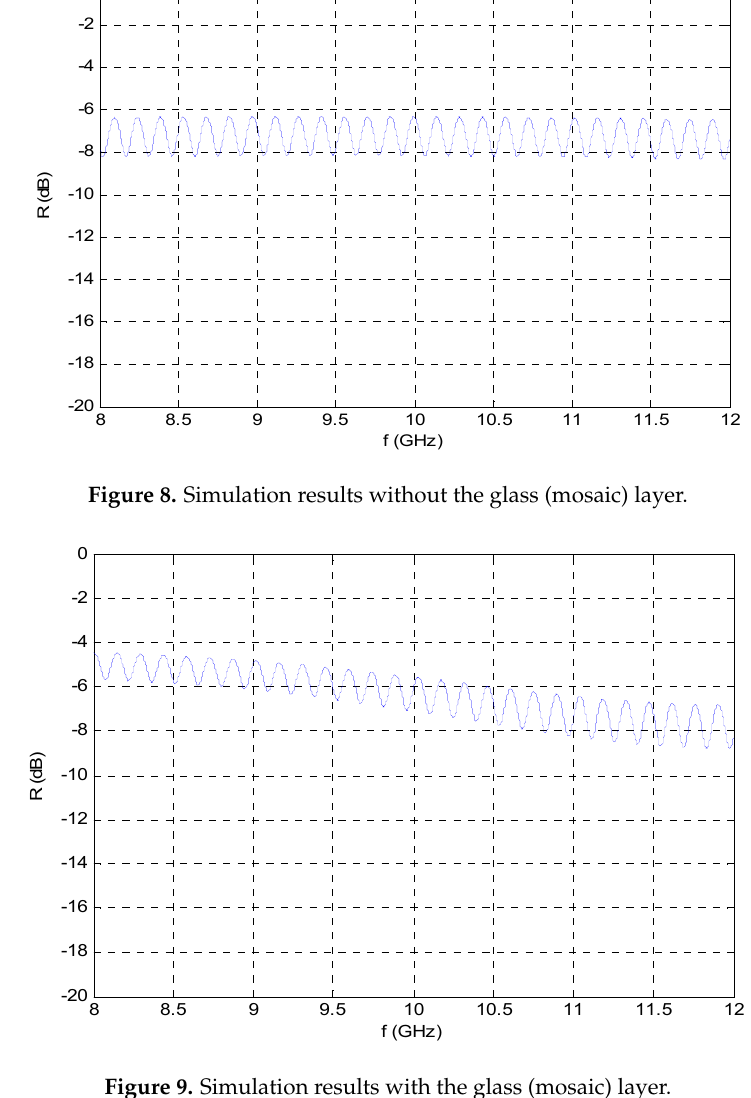
Figure 9. Simulation results with the glass (mosaic) layer.